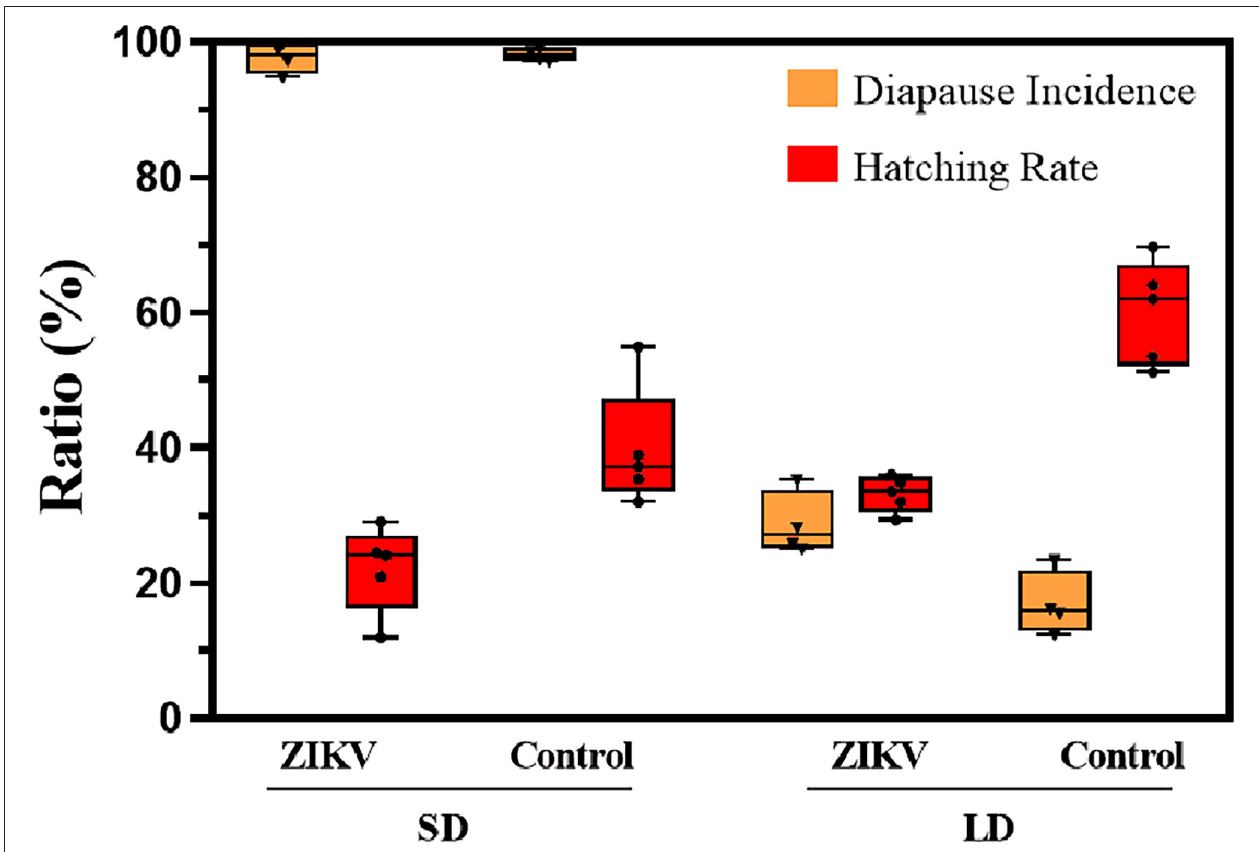
FIGURE 4 | Diapause incidence and hatching rate of ZIKV infection eggs and uninfected control eggs under SD and LD conditions. LD, non-diapause-inducing long-day photoperiod; SD, diapause-inducing short-day photoperiod. Each point represents replicate test. Error bars indicate SDs.